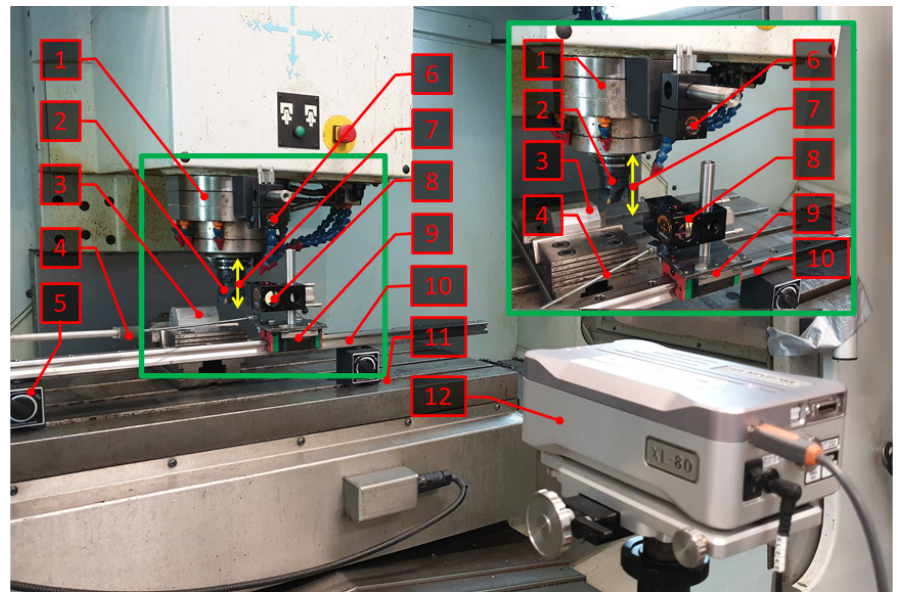
Figure 4. Test bench for measuring relative displacement in a tool-workpiece system. 1—spindle; 2—milling head; 3—workpiece; 4—link; 5—magnetic base; 6—linear reflector; 7—displacement in the tool-workpiece system; 8—linear interferometer rail; 9—block; 10—rail; 11—table; 12—XL 80 laser.